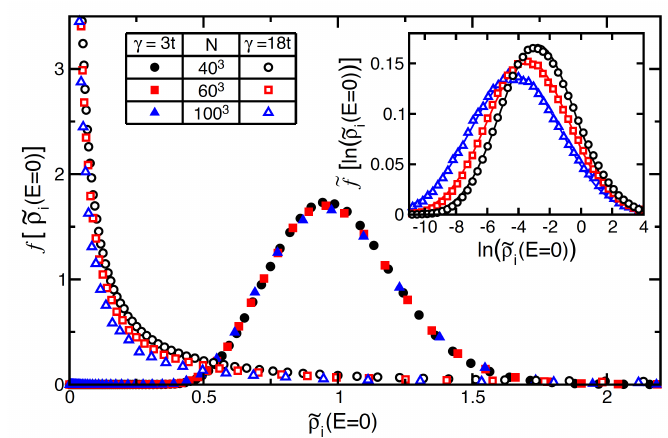
Figure 7. The distribution of the local density of states at the band center (zero energy) in a single-band Anderson model with disorder strength γ / t where t = 1 is the near-neighbor hopping. Near the localization transition, γ / t = 16.5 the distribution becomes log-normal (see also the inset) for over ten orders of magnitude, while for values well below the transition, γ /3 is shown, the distribution is normal [106].